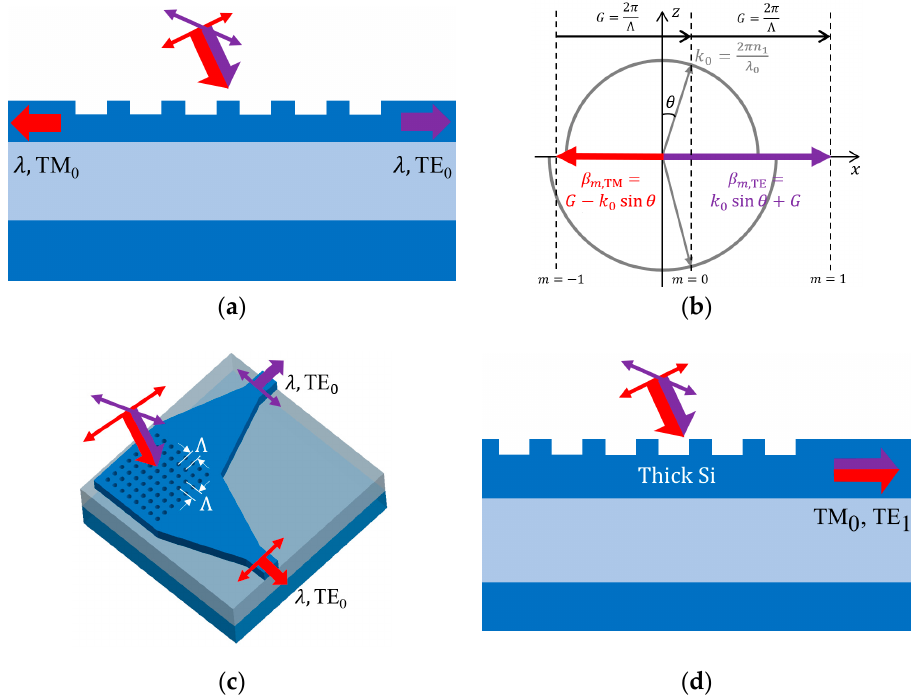
Figure 7. GCs with polarization diversity: (a) 1D polarization splitting grating coupler (PSGC) with traverse electric (TE)/ traverse magnetic (TM) polarizations coupled to TE 0 /TM 0 waveguide modes in contrary directions; (b) wave ‐ vector diagram for 1D PSGC; (c) 2D PSGC with TE/TM polarizations coupled to TE 0 waveguide modes in orthogonal directions; and (d) thick silicon ‐ on ‐ insulator GC for polarization ‐ insensitive coupling.